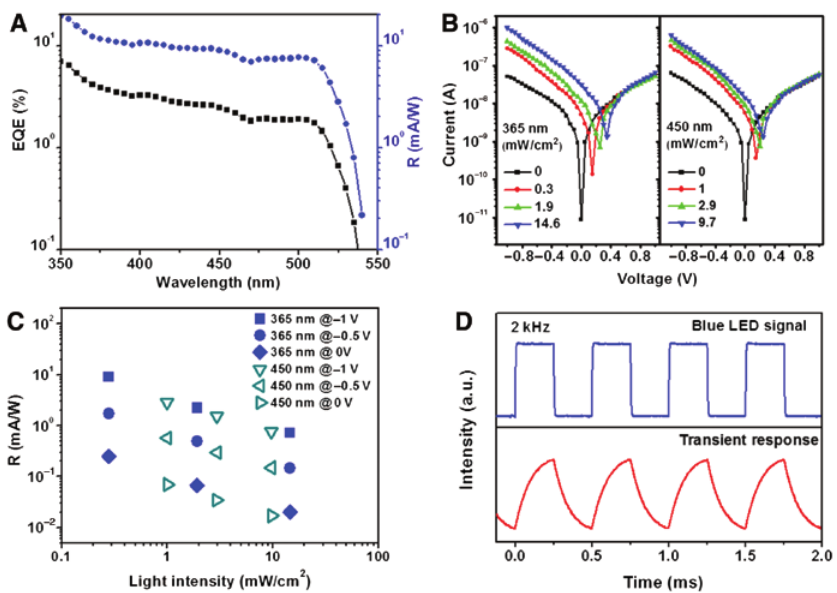
Figure 5: Photo-response properties of the bi-functional diodes. (A) EQE and corresponding photoresponsivity of the bi-functional diode at 0 V bias, (B) the photo current–voltage characteristics measured for the bi-functional diodes using two LED sources with different peak EL wavelengths of 365 and 450 nm under different light intensities. (C) The photoresponsivity–light intensity characteristics measured for the bi-functional diode operated at different reverse biases using two LED light sources. (D) The transient photo-response of the bi-functional diode operated at 0 V under a 2 kHz-modulated 450 nm blue light LED